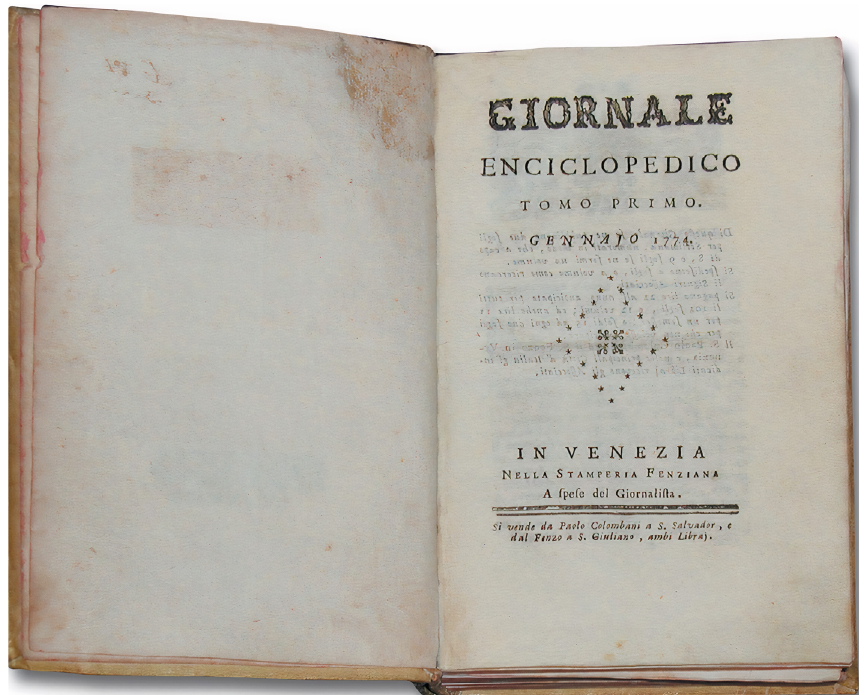
Fig. 2 Title page of the first issue of the Giornale enciclopedico (January 1774), photographed by Ettore Castiglieri. Wikimedia Commons, CC BY-SA